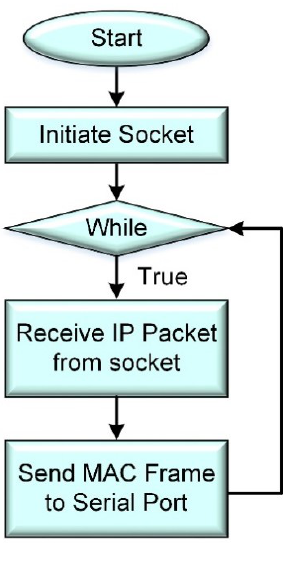
Figure 7. Flowchart for delivery the MAC frame